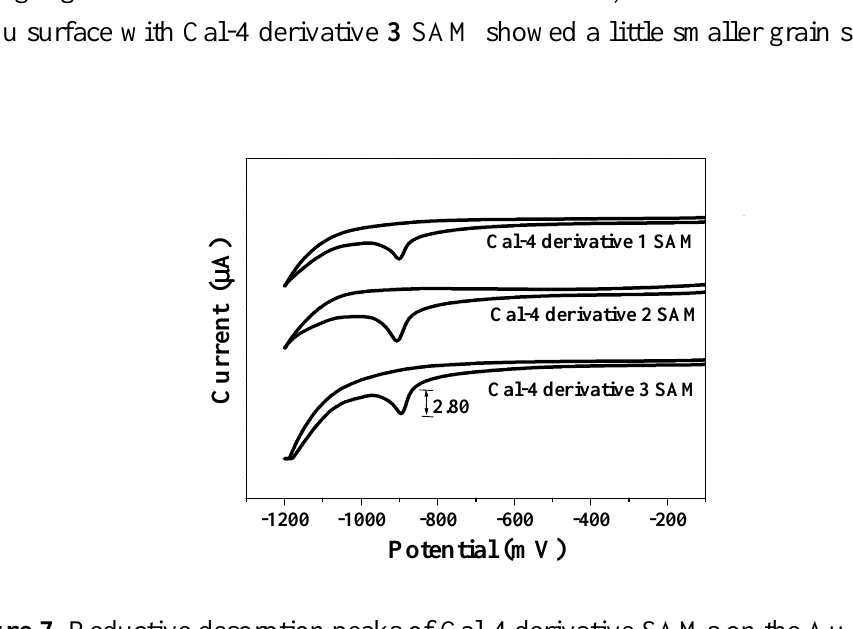
Figure 7. Reductive desorption peaks of Cal-4 derivative SAMs on the Au electrode surface. Table 3. Surface coverage of Cal-4 derivative SAMs on Au electrode